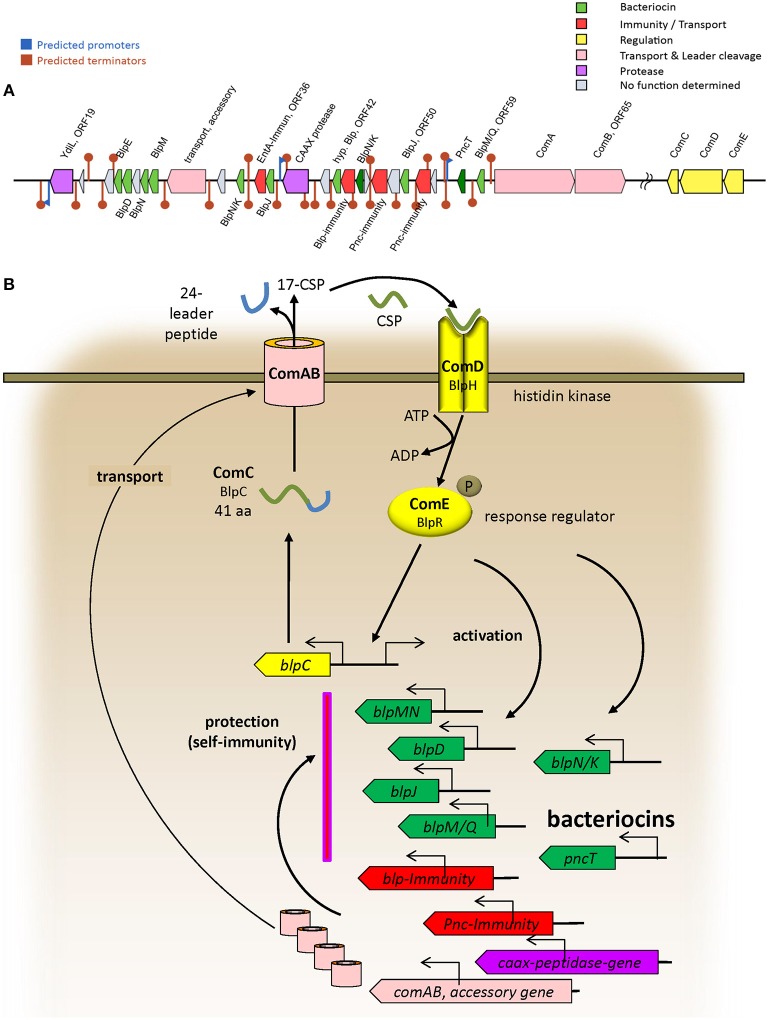
(A) Architecture of bacteriocin related operons in the probiotic strain 7746 according to BAGEL4 and improved by manual BLAST search. Only the most representative operons are presented. (B) Model of bacteriocin-related protein interactions deduced from Conrads et al. (2014) and Miller et al. (2016).